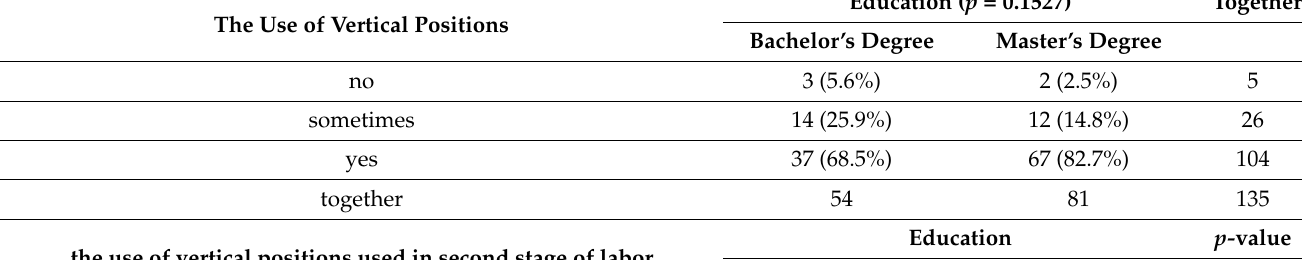
Table 3. Education of surveyed midwives versus the use of non-pharmacological methods of relieving labor pain and assessment of the degree of preparation for the use of vertical